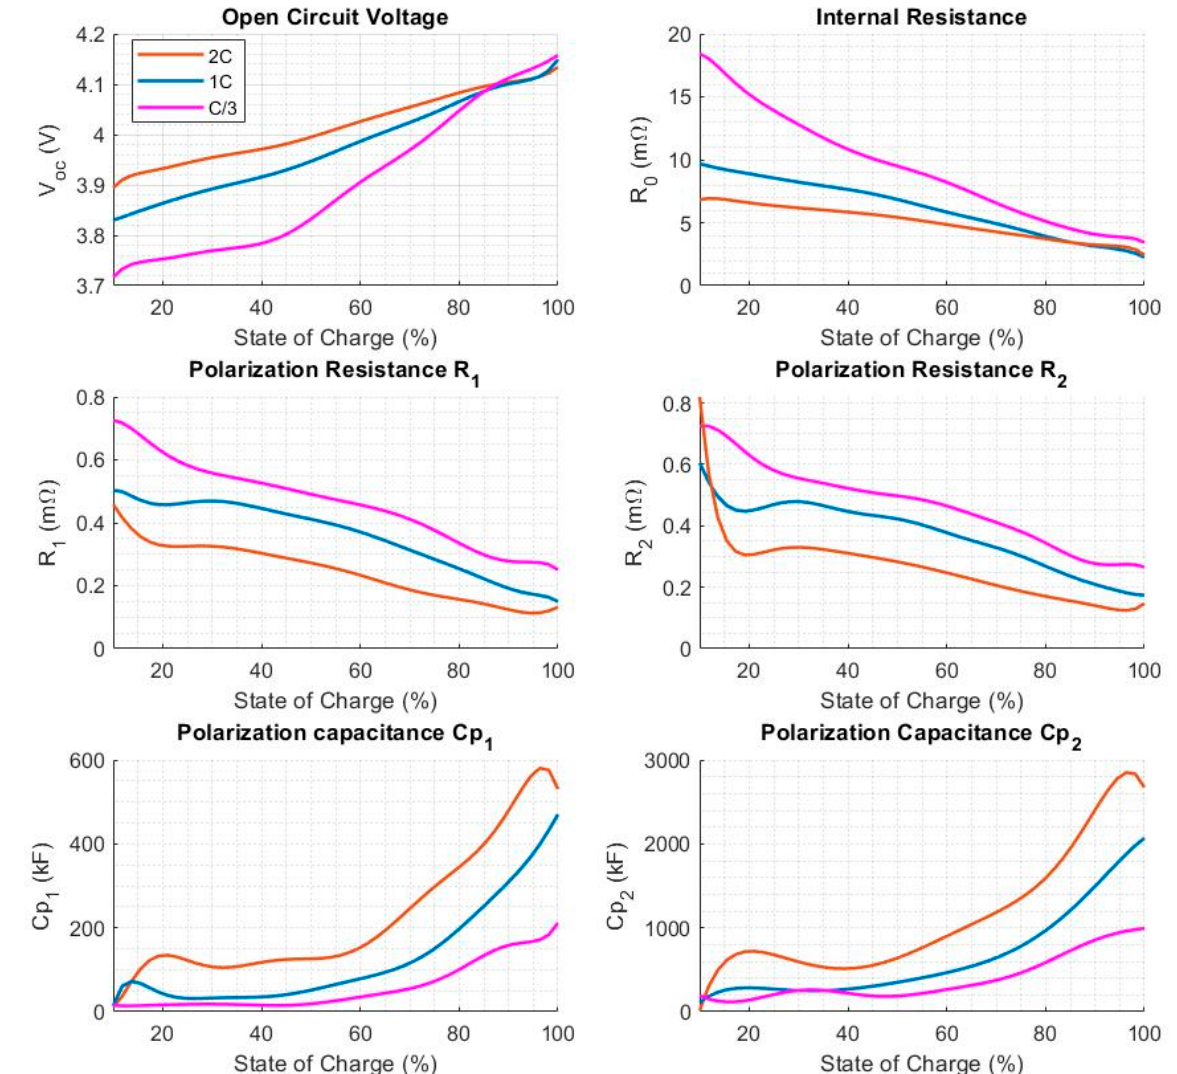
Figure 6. Estimated parameters—Second order Thévenin model.